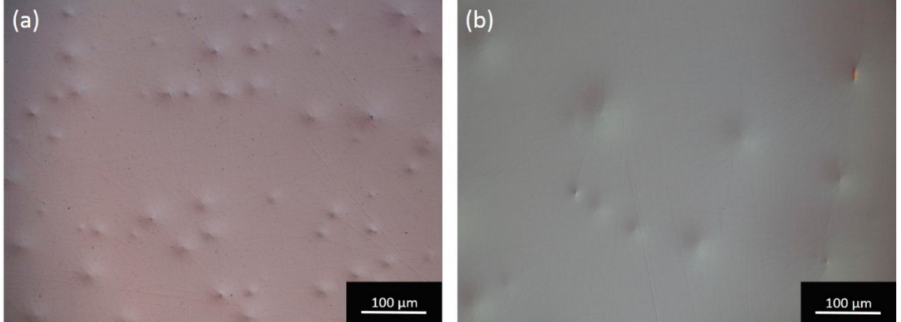
Figure 10. Optical microscope image in Normarski configuration of the KY(WO 4 ) 2 surface polished on a pink polyurethane disk with 3 µ m CeO 2 suspension for ( a ) 30 min and ( b ) 90